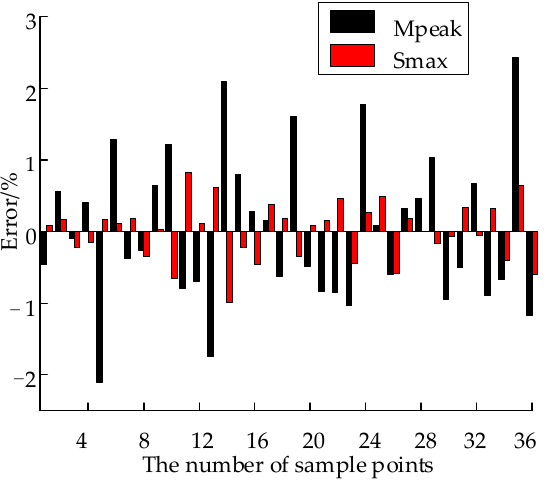
Figure 11. REs of M peak and S max . Table 3. Errors of the test sample points. Table 3. Errors of the test sample